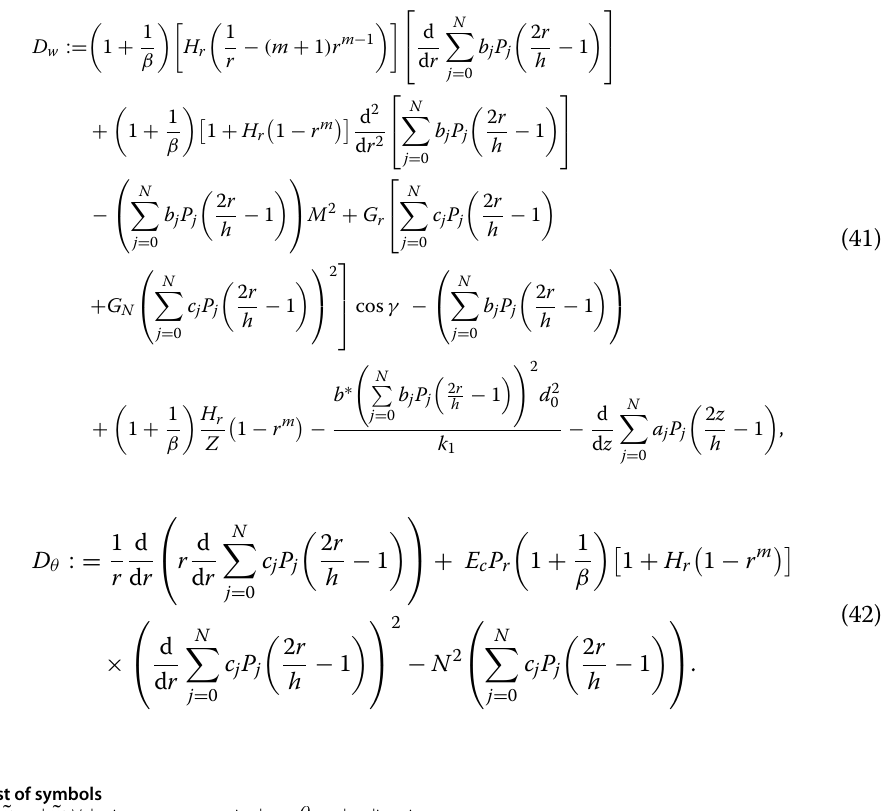
List of symbols ˜ u , ˜ v and ˜ w Velocity components in the r , θ , and z directions